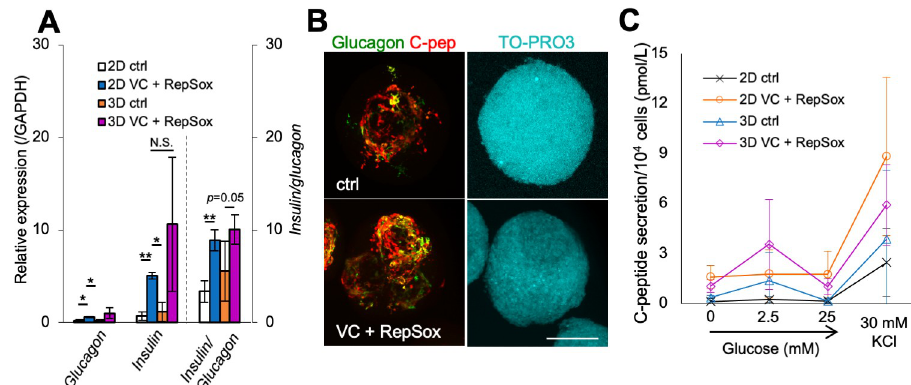
Fig 5. Insulin responsiveness obtained by 3D culture. ( A ) qRT-PCR analysis of the expression normalized against GAPDH and insulin/glucagon at stage 4. 2D control, white; 2D VC + RepSox, orange; 3D control, blue; 3D VC + RepSox, magenta. The data show the average of three experiments (each result was showed in S4B–S4D Fig). � p < 0.05, �� p < 0.01; paired t -test. ( B ) IHC of 3D culture cell at stage 4. The expression of glucagon (green) and C- peptide (red). TO-PRO3 staining (DNA) shown in blue. Maximum intensity projection of z-stack images. Scale bar, 100 μ m. ( C ) C-peptide secretion determined by ELISA. 2D control, black; 2D VC + RepSox, orange; 3D control, blue; 3D VC (vitamin C-treated) + RepSox, magenta. The data show the average of three experiments.